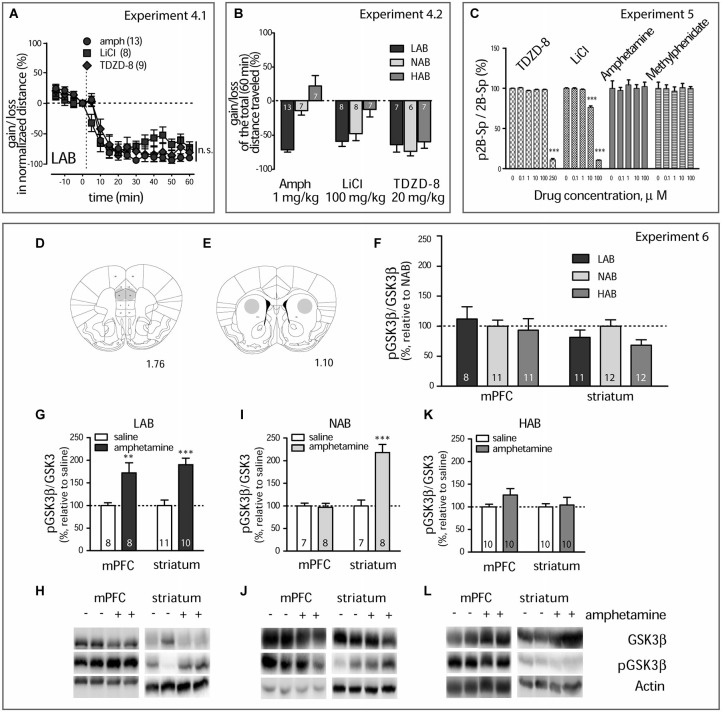
Amphetamine treatment results in GSK3β inhibition (A). Amphetamine (1 mg/kg, i.p., circles), LiCl (100 mg/kg, i.p., squares), and TDZD-8 (20 mg/kg, i.p., diamonds) mitigate the locomotor activity in LAB mice with the same dynamics. The dashed line defines the moment of drug injection; n.s. non significant. (B). Within-line comparison of amphetamine (1 mg/kg, i.p.), LiCl (100 mg/kg, i.p.), TDZD-8 (20 mg/kg, i.p.), and saline effects on the locomotor activity in LAB, NAB, and HAB mice illustrates the similar ability of all drugs to decrease the traveled distance in LAB mice. Relative gains or losses in the mean distance traveled within 60 min after treatment was obtained in comparison to basal activities (last 5 min of pre-treatment 20 min period). Analysis confirms the selectivity of amphetamine action in LAB mice and points to a lack in line specify of LiCl and, in particular, TDZD-8 to inhibit locomotion. *p < 0.05, **p < 0.01, ***p < 0.001, within line comparison, Bonferroni’s post hoc test. Numbers on the bars represent the group size. The same order of treatments was applied for each line. (C). Lithium chloride and TDZD-8 show a direct inhibition of recombinant GSK3β in vitro effectively reducing (p < 0.001) its activity in a dose-dependent manner. Neither amphetamine nor methylphenidate inhibit recombinant GSK3β in vitro. (D,E). Schematic representation of punched areas in the mPFC and the striatum. The computer-based atlas by Paxinos and Franklin (2001) was used to mark probe locations; numbers refer to distances from the bregma, mm. (F). Western blot kinase analysis for the mPFC and the striatum of drug naïve mice shows no difference between LAB (n = 8/11), NAB (n = 11/12) and HAB mice (n = 11/12) in pGSK3β levels. (G,I,K). Changes in the pGSK3β levels in the mPFC and the striatum of LAB, NAB, and HAB mice 60 min after amphetamine (1 mg/kg, i.p.) and saline treatment and coinciding with OF exposure. **p < 0.01, ***p < 0.001 vs. saline (H,J,L). Representative Western blots for analysis of GSK3β, pGSK3β protein level. Bands include samples both from amphetamine and saline-treated animals. Numbers on the graph panels represent group size.